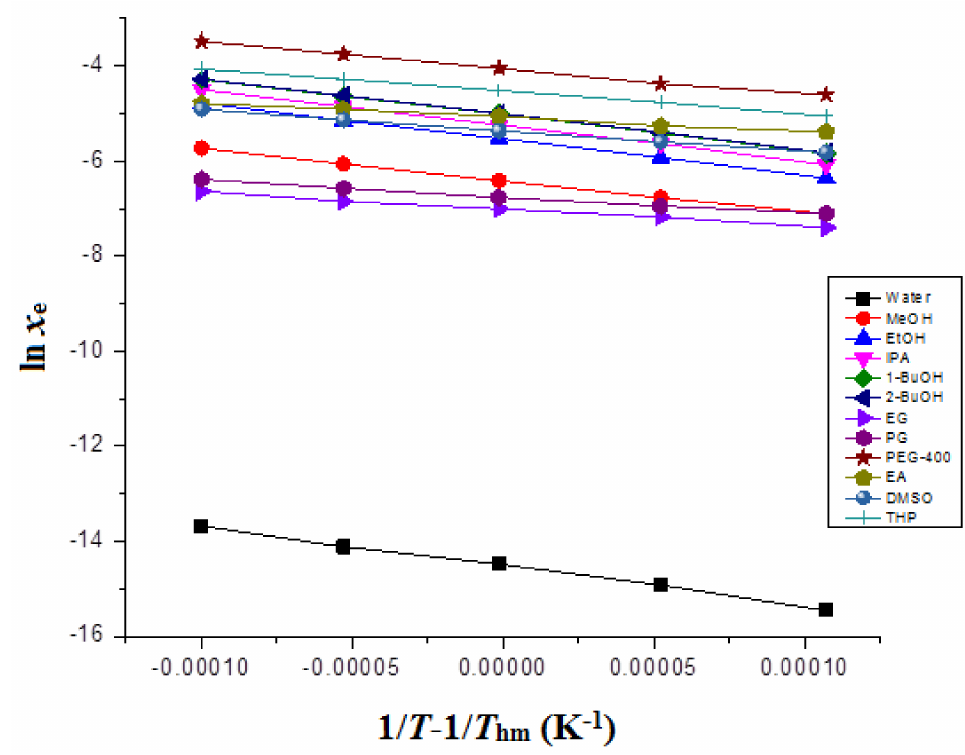
Figure 2. van’t Hoff plots for FBX plotted between ln x e and 1/ T − 1/ T hm for FBX in different mono